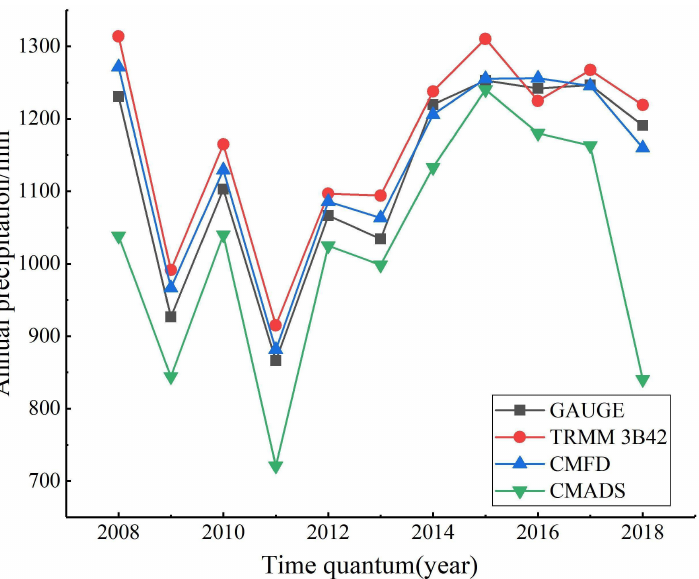
Figure 2. Annual average precipitation variation from 2008–2018 for products and site